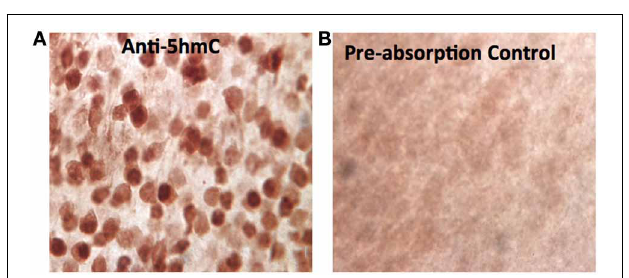
FIGURE A1 | The specificity of the anti-5hmC antibody. The specificity of the crucial anti-5hmC antibody against 5hmC was characterized by pre-absorption of anti-5hmC antibody (1:1000, rabbit polyclonal IgG, Active Motif) with 5hmC synthesized DNA (Methylated DNA Standard Kit, #55008, Active Motif, 50ng/ μ l, at a working dilution of 1:20 molar ratio) overnight at 4 ◦ C. Before absorption, the anti-5hmC immunostaining in the cortex shows distinct 5hmC staining pattern (A) as described in the result, while the staining pattern was abolished or drastically reduced after 5hmC-preabsorption (B) .